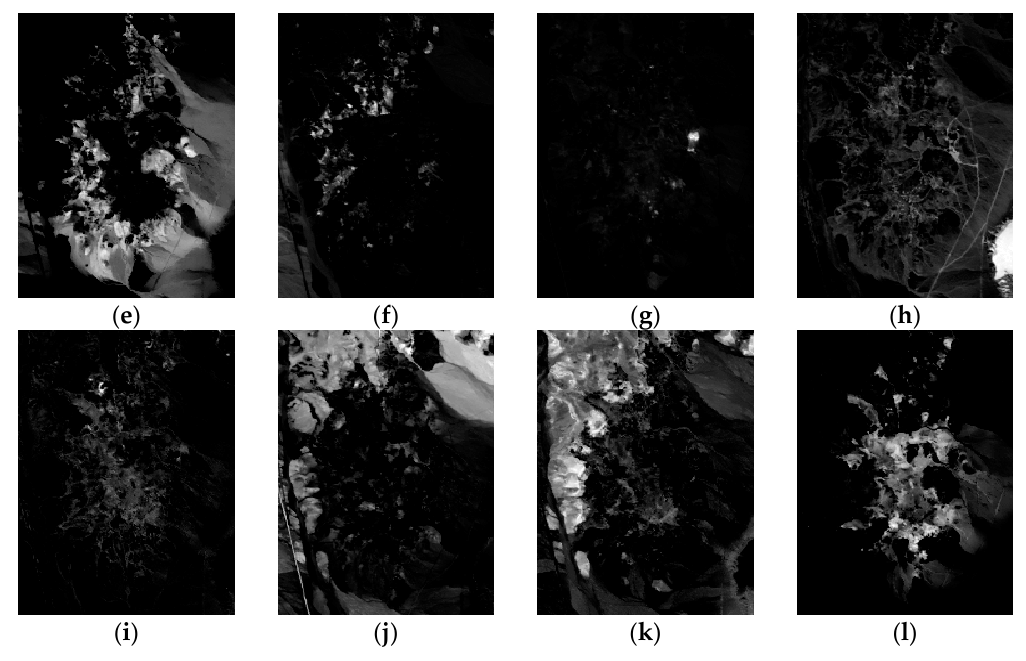
Figure 12. Abundance maps of endmembers estimated by BF- L 2 SNMF on the Cuprite data set: ( a ) Alunite, ( b ) Andradite, ( c ) Buddingtonite, ( d ) Dumortierite, ( e ) Kaolinite_1, ( f ) Kaolinite_2, ( g ) Muscovite, ( h ) Montmorillonite, ( i ) Nontronite, ( j ) Pyrope, ( k ) Sphene, and ( l )